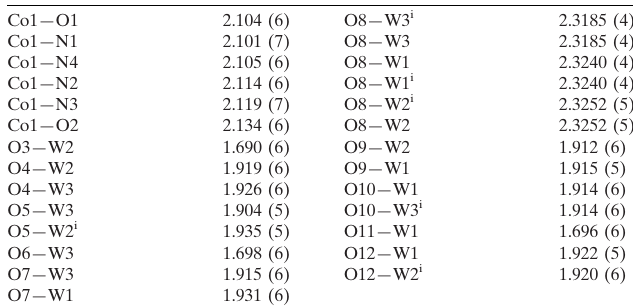
Selected bond lengths (A˚